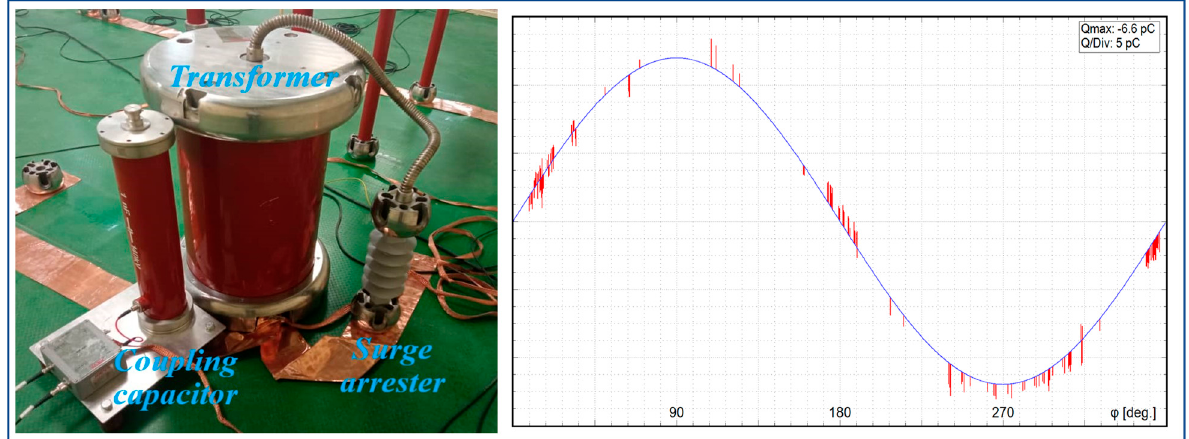
Figure 3. The experimental setup for electrical partial discharge with a sample of its outcome.